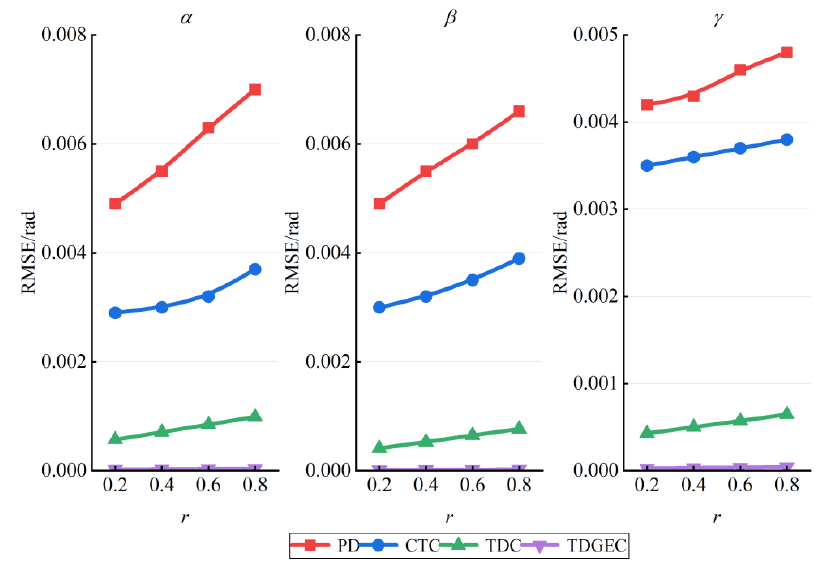
Figure 7. RMSE under different r .